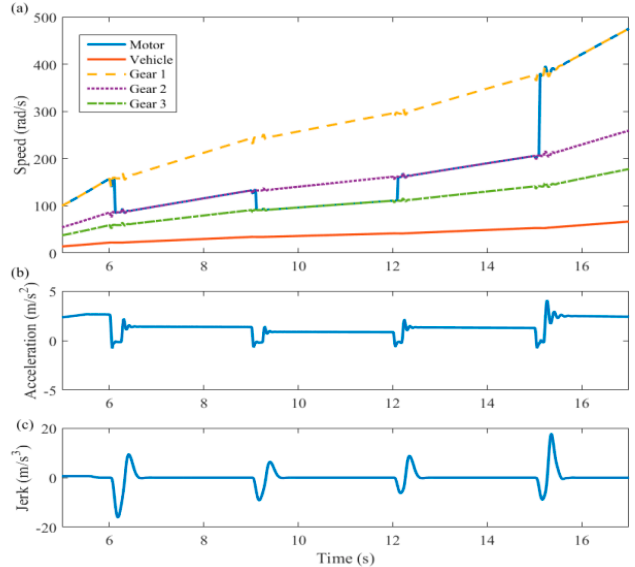
Figure 2. Up and down shift transients for clutchless automated manual transmission (AMT) powertrain for a 20 ms stage duration at 200 Nm motor torque ( a ) system speeds, ( b ) vehicle longitudinal acceleration, and ( c ) vehicle longitudinal jerk.